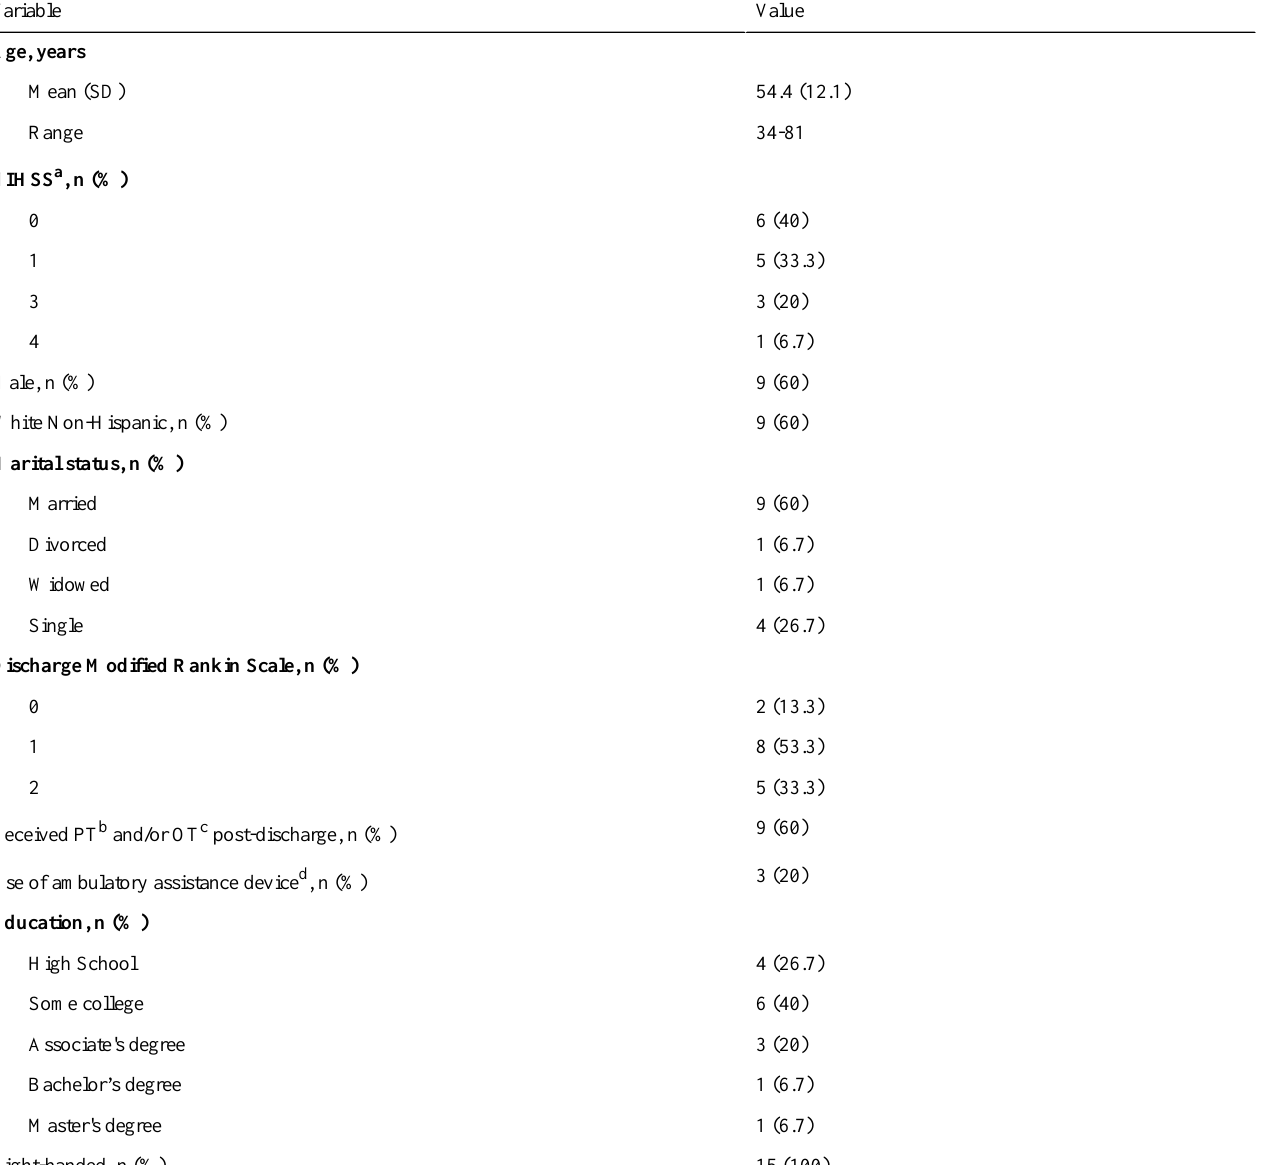
Table 1. Participant characteristics